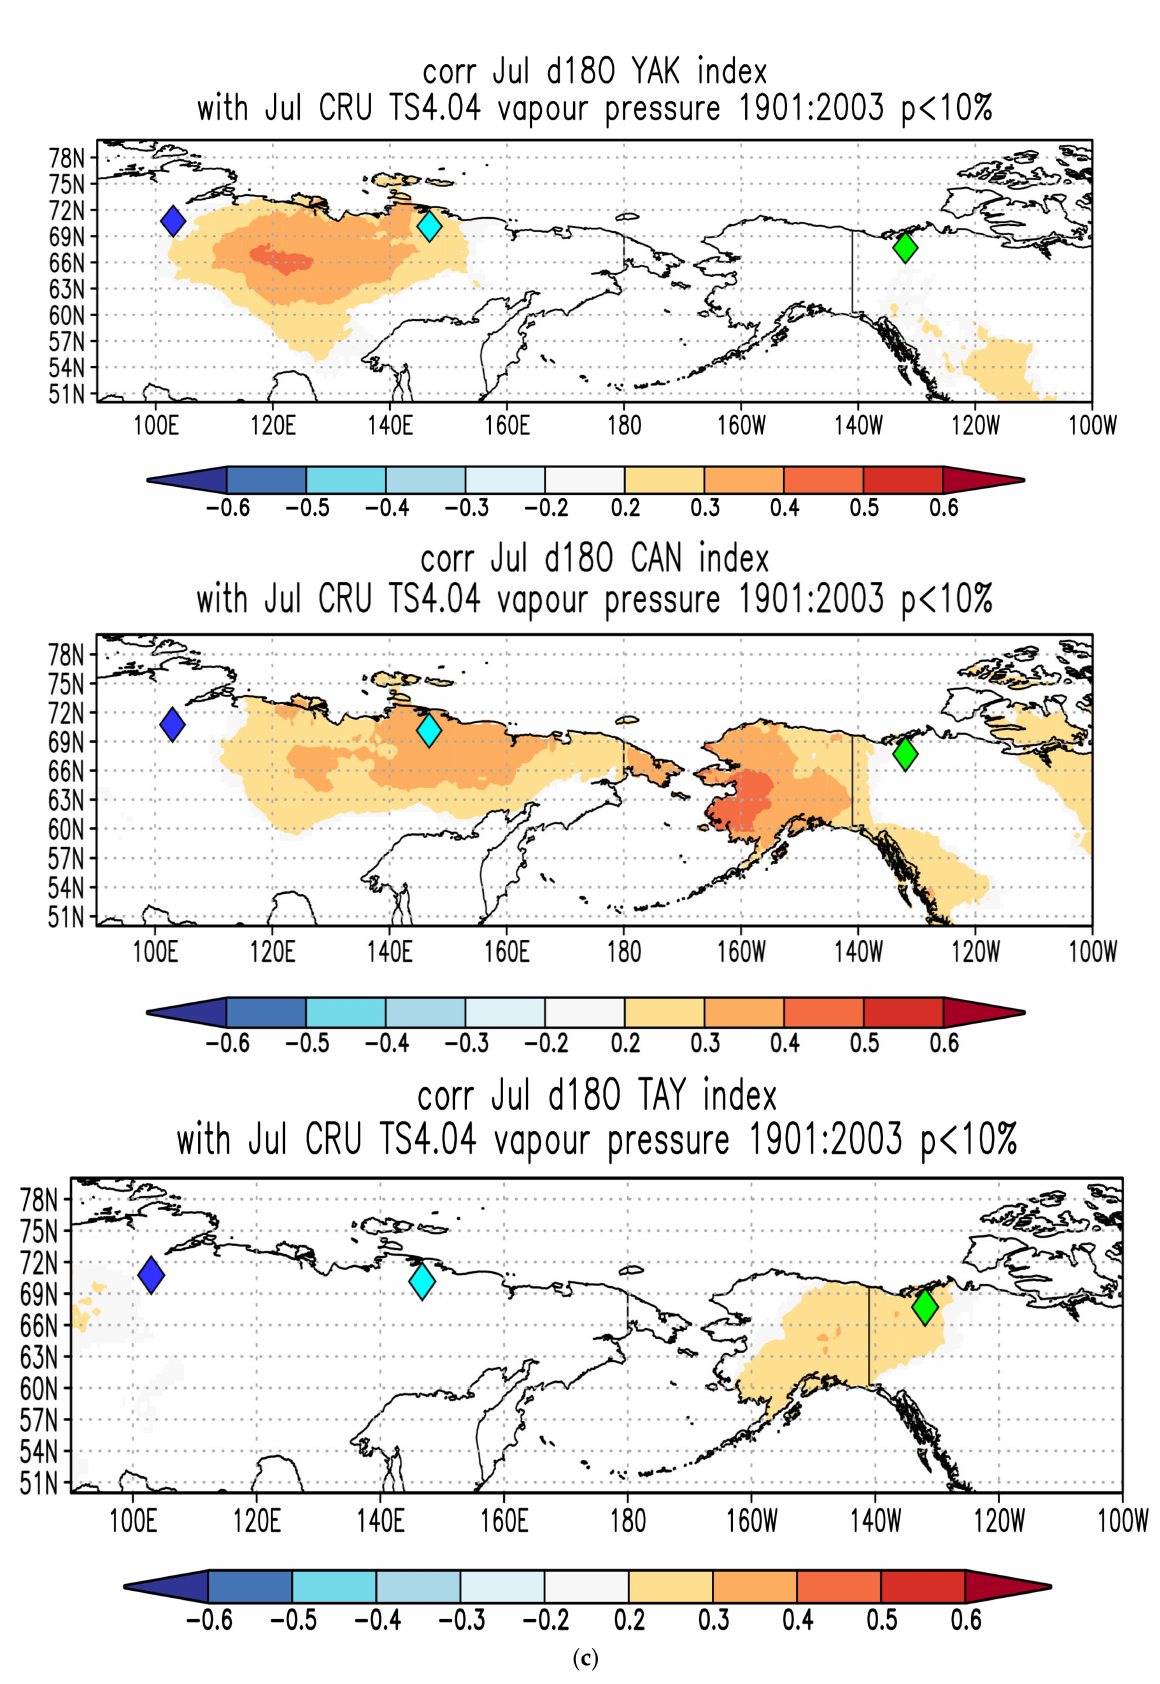
Figure 8. Spatial distribution of correlation coefficients within gridded net 0.5 ◦ , p < 0.01 between δ 18 O cell and air temperature ( a ), precipitation ( b ) and VPD ( c ) for TAY, YAK and CAN,